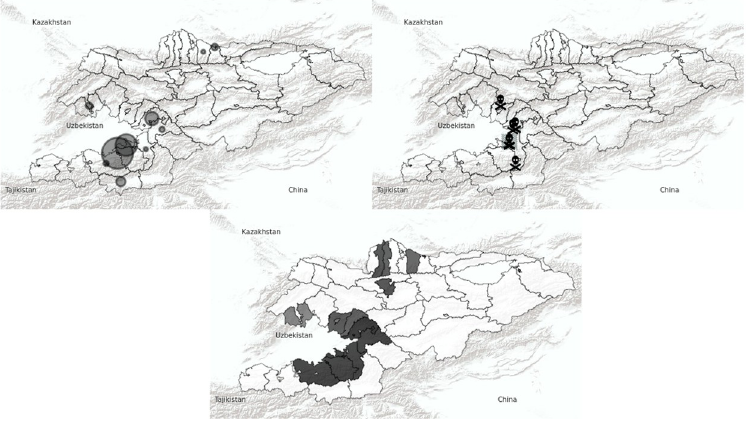
Fig 2. Maps of local forced displacement, deaths and horizontal inequality in 2010. Upper left pane: Forced displacement (Source: [7]). Upper right pane: Estimated casualties (Source: [9]). Lower pane: Horizontal inequalities (Source: Own calculations based on